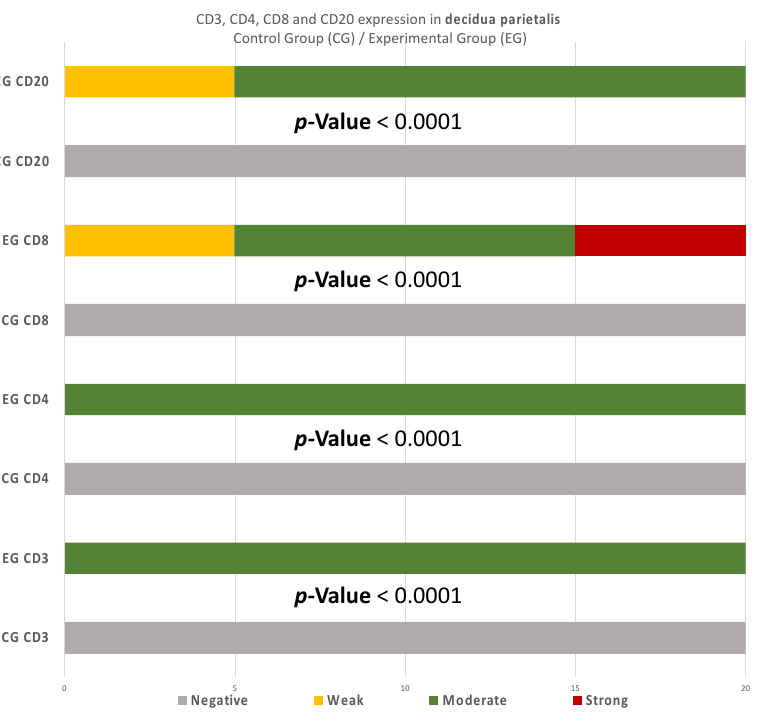
Figure 8. Evaluation of CD20 antigen positive expression. Control group (CG): ( Α ) Negative CD20 expression in the DP (4 × 4 magnification). ( Β ) Negative CD20 expression in the DB (4 × 4 magnifi- cation).